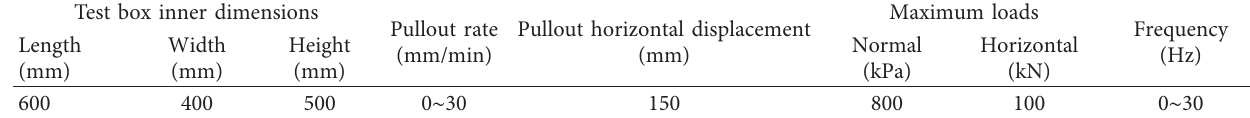
Table 1: Main technical parameters of static and dynamic pullout